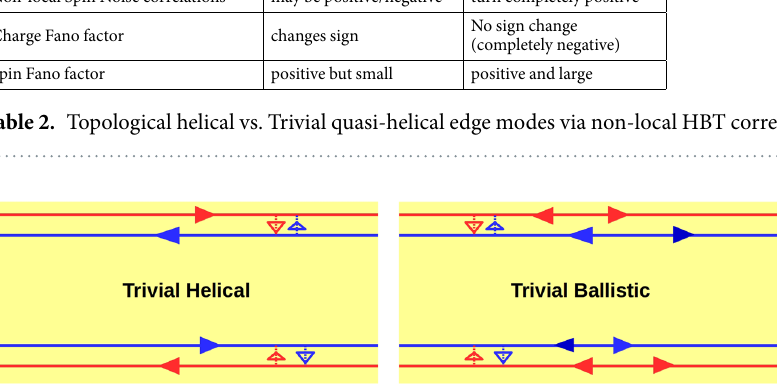
Figure 9. ( a ) Spin-momentum locked trivial quasi-helical edge modes, ( b ) Trivial ballistic modes without spin- momentum locking. For case ( b ), since spin-momentum locking is broken, it is more appropriate to address these modes as ballistic although for representative comparison with the spin-momentum locking case they are shown similar to the edge modes in ( a ), in actuality they are anything but, the two arrows one pointing left and another pointing right on the same mode indicate backscattering while the dashed arrows linking up and down spin modes indicate spin-flip